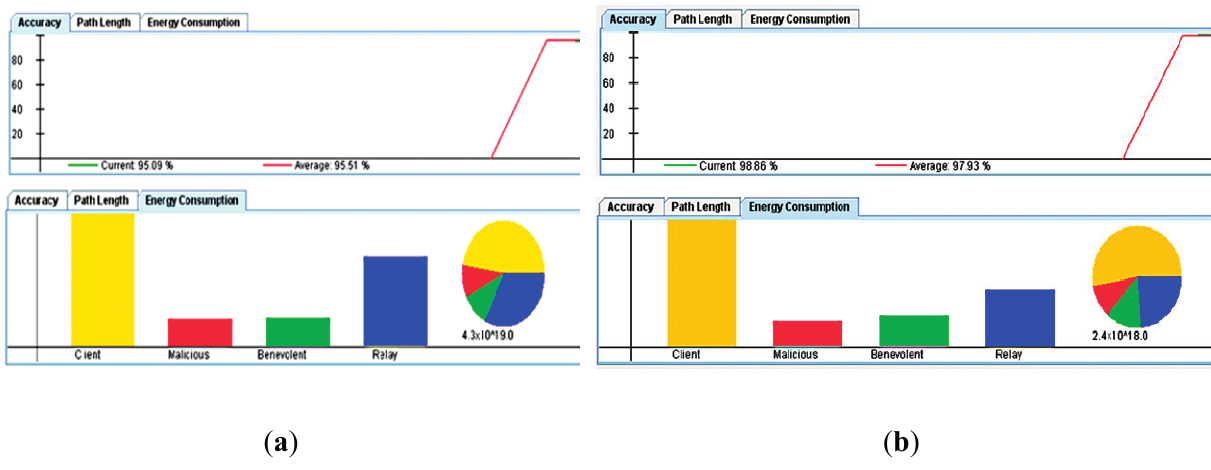
Figure 10. Study of the effect of maliciouesness: ( a ) High maliciousness; and ( b ) Low